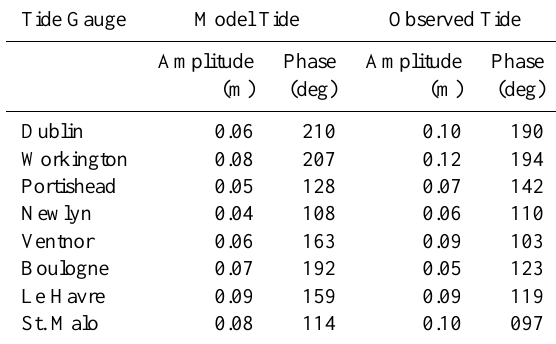
Table 1. Amplitude and phase of M2 tide calculated by the model compared with observations at representative tide gauges.